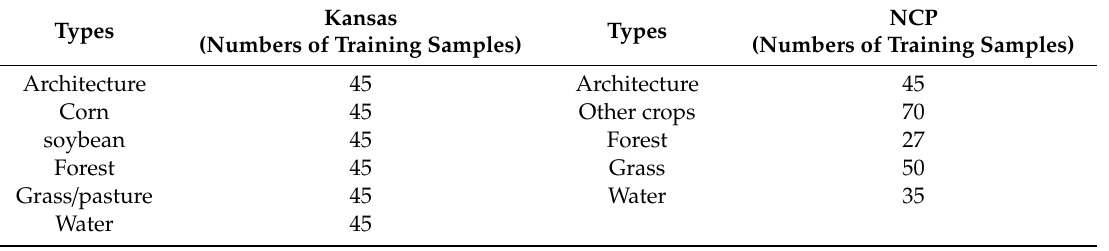
Table 4. Training sets for evaluating the Je ff ries–Matusita (JM) distance among di ff erent types for two study